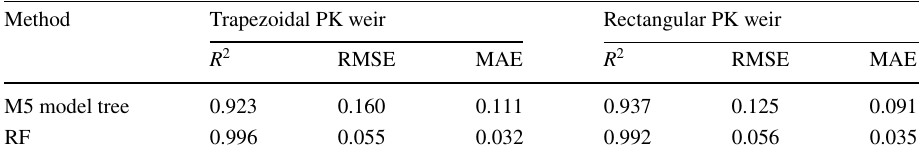
Table 3 Performance measures for applied modelling approaches